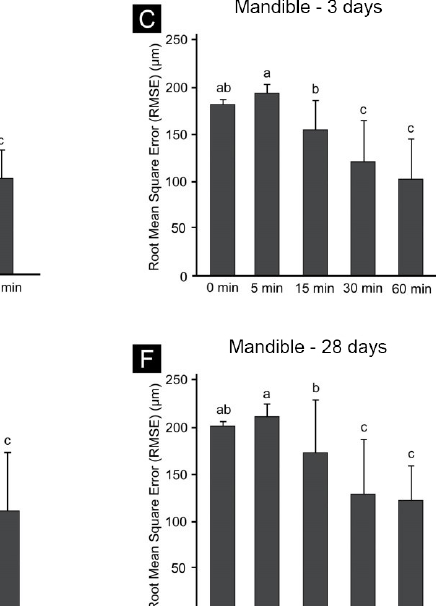
Figure 5. RMSE values at ( A ) 0 days, ( B ) 1 day, ( C ) 3 days, ( D ) 7 days, ( E ) 14 days and ( F ) 28 days after the maxilla printing process. Data are mean and standard deviation values. Different lowercase letters in a single graph indicate significant differences.